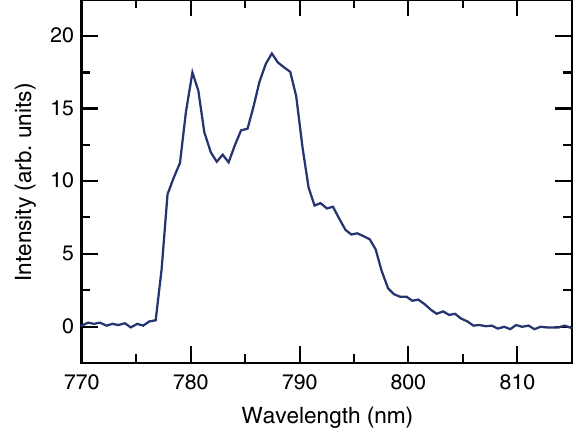
FIG. 3 (color online). Typical laser spectrum of the Ti:Sa oscillator with central wavelength λ ¼ 787 nm. The cor- responding pulse duration is τ autocorrelator.